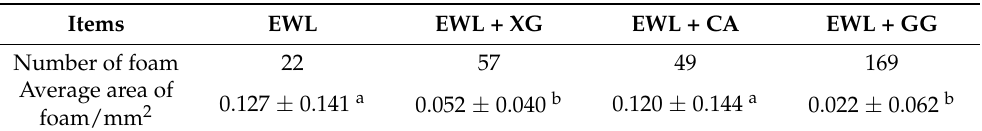
Figure 2. Effects of polysaccharide added to egg white liquid on foam structure. ( a ) The foam volume after full foaming in the presence of polysaccharides of egg white liquid. Different letters indicate a significant difference ( p < 0.05) between groups. ( b ) The microscopic images of the foam in the presence of polysaccharides of egg white liquid (10 × ). Table 1. Effects of polysaccharide added to egg white liquid on average area and quantity of foam. Different letters in the same row indicate a significant difference ( p < 0.05) between groups.